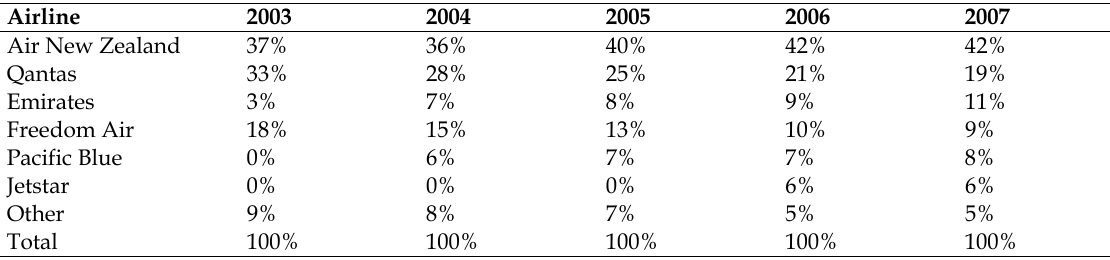
Table 2. Trans Tasman Aviation Market Share